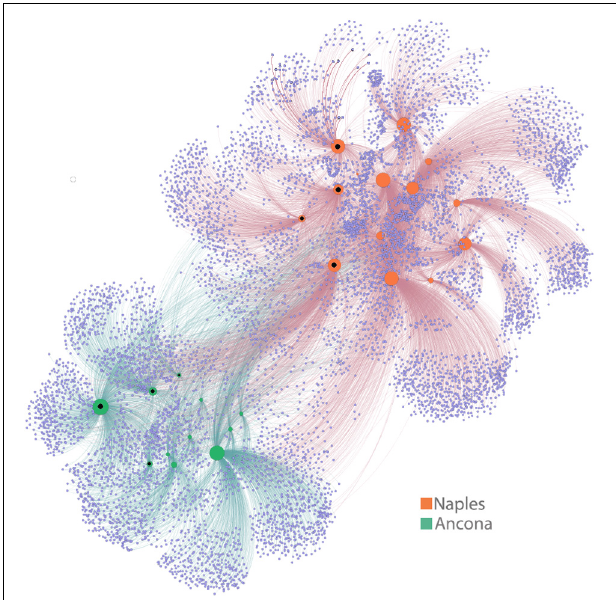
FIGURE 5 | Network analysis. The visual output of this analysis is a clustering of samples according to their shared ASVs – i.e., samples that share more ASVs cluster closer together. The degree to which samples cluster is based on the number of ASVs shared between samples (when ASVs are found in more than one sample) and this is weighted according to the number of sequences within an ASV. In the network diagram, there are two kinds of “nodes” represented, ASV-nodes (light violet nodes) and sample-nodes (green = AN, orange = NAP samples). If an ASV is found within a sample, the two nodes (sample node and ASV node) are connected with a line (an “edge”). Inner black dots in sample nodes indicate environmental (seawater or sediment) samples. The size of the sample nodes is proportional to their degree of connection, i.e., highly connected sample nodes are bigger than those with fewer